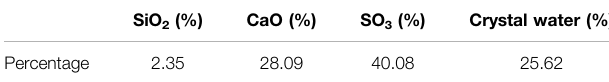
TABLE 1 | Main chemical composition of